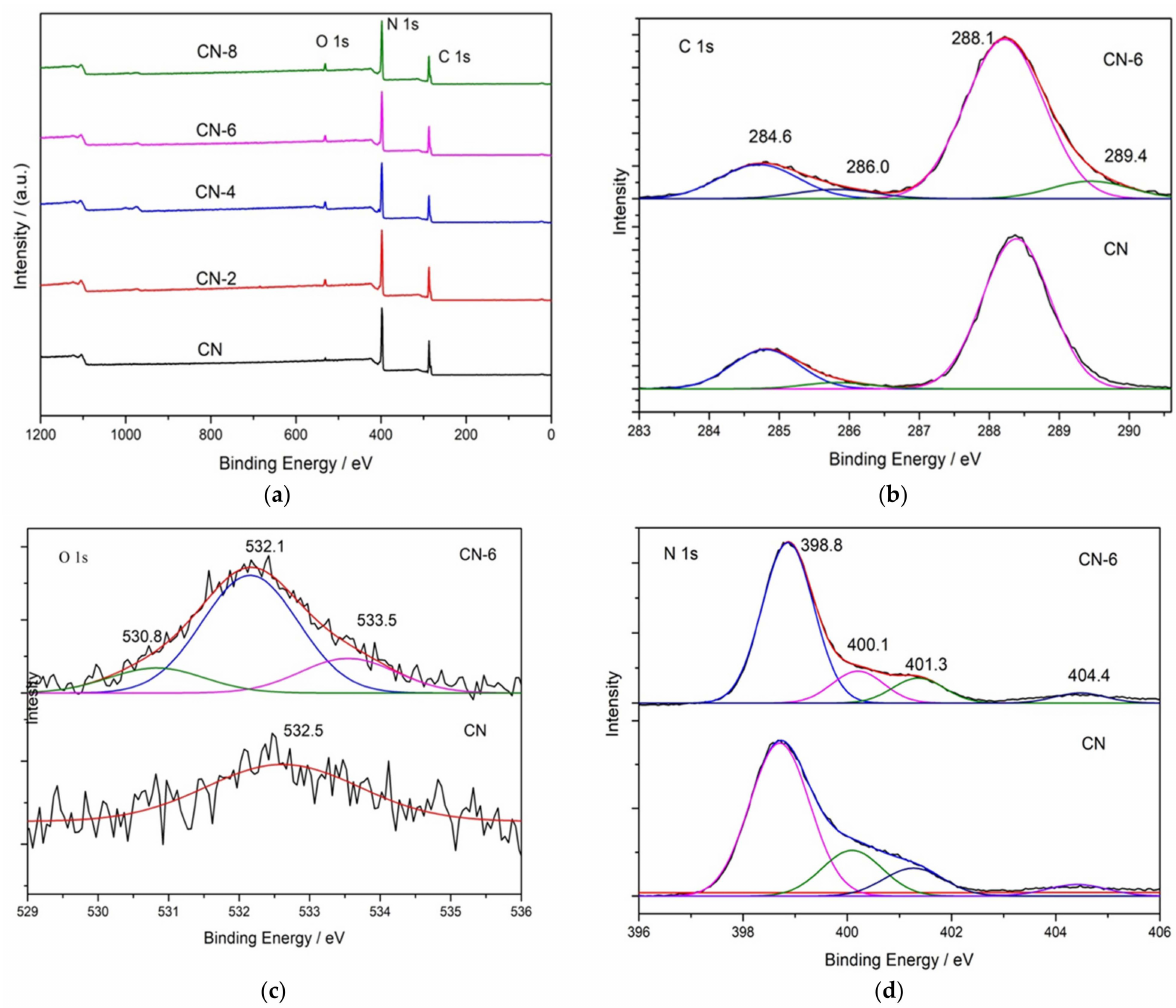
Figure 4. XPS survey of all samples ( a ) and high-resolution spectra in C 1 s ( b ), O 1 s ( c ), and N 1 s ( d ); binding energy regions of CN and CN-6.